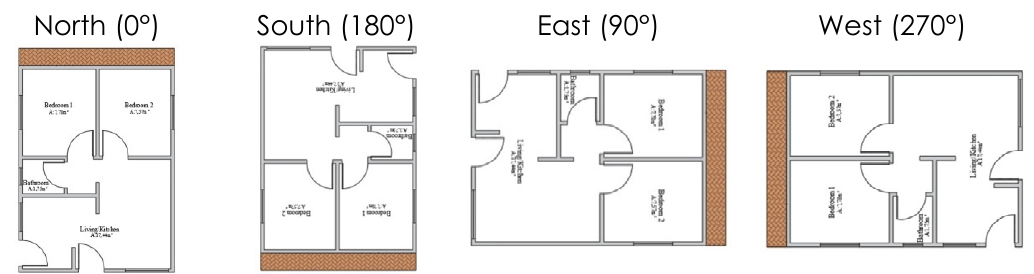
Figure 3. Schematic section of the bermed earth-sheltered wall located in the bedrooms.